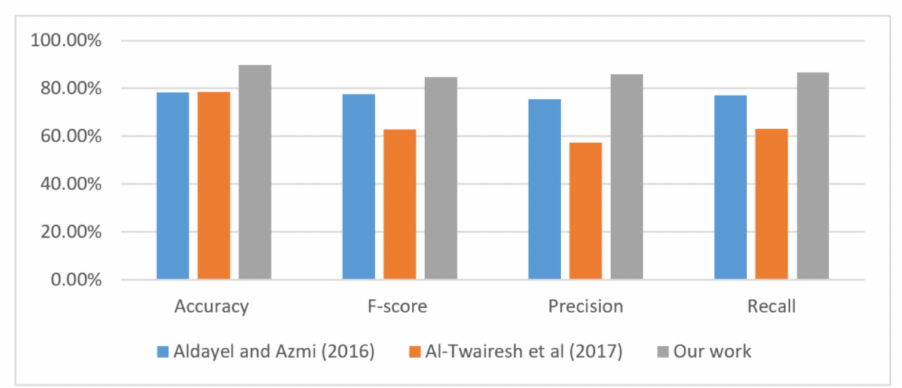
Figure 3. Findings from Al-Twairesh and Adayel corpora using our LX-based